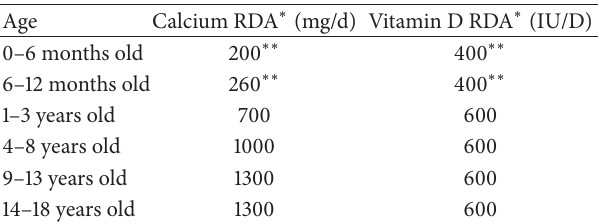
Table 2: Recommended daily allowance for calcium and vitamin D